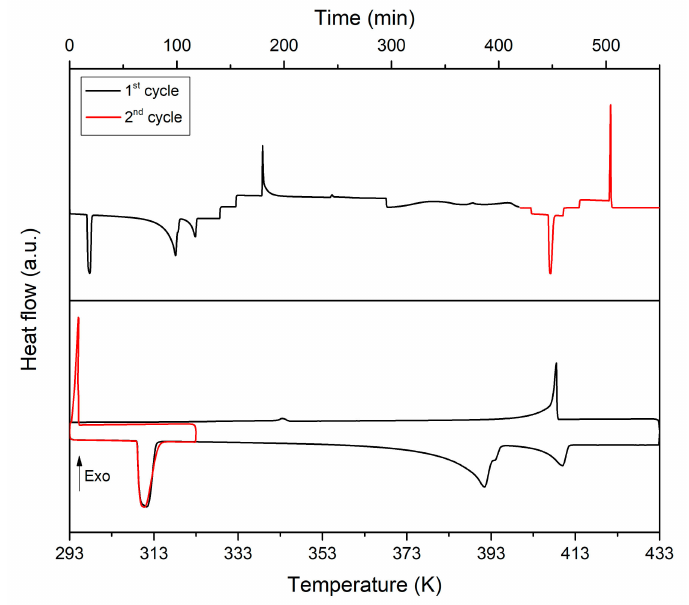
Figure 10. DSC results obtained for the NPG-TRIS sample with composition equal to 0.485 mole fraction of TRIS with heating / cooling rate of 1 K / min and annealing for 1 h at 293 K between the first and second